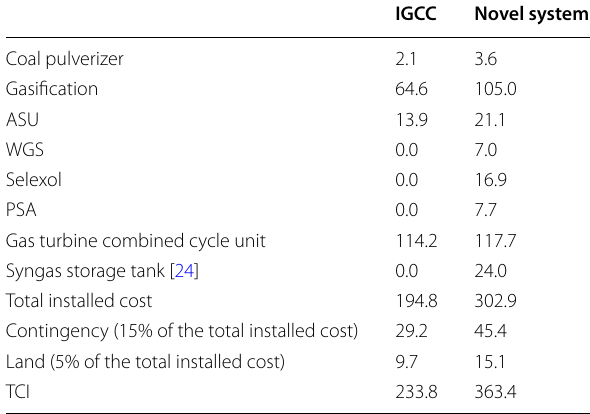
Table 8 CAPEX of the process units of the IGCC system and the novel system (M$)